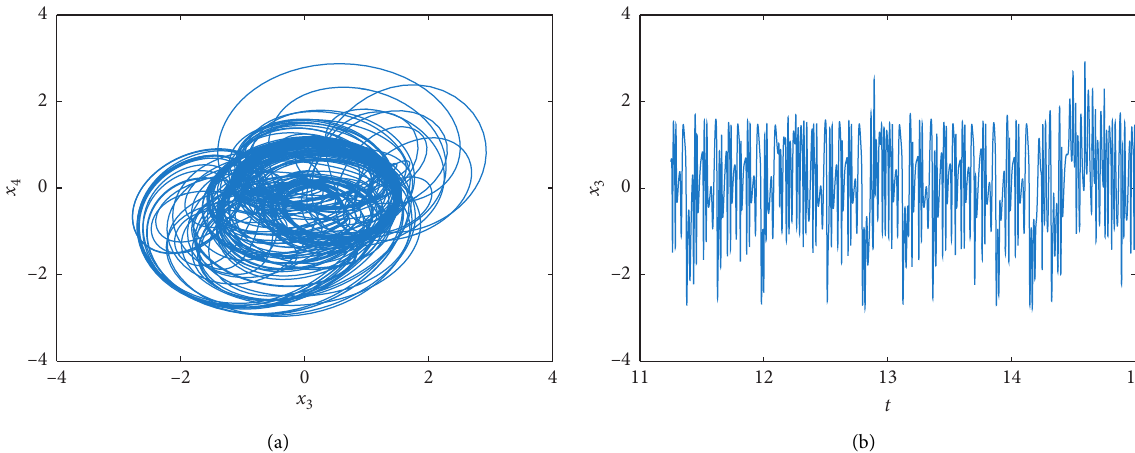
Figure 14: Phase portrait on plane ( x motion when P